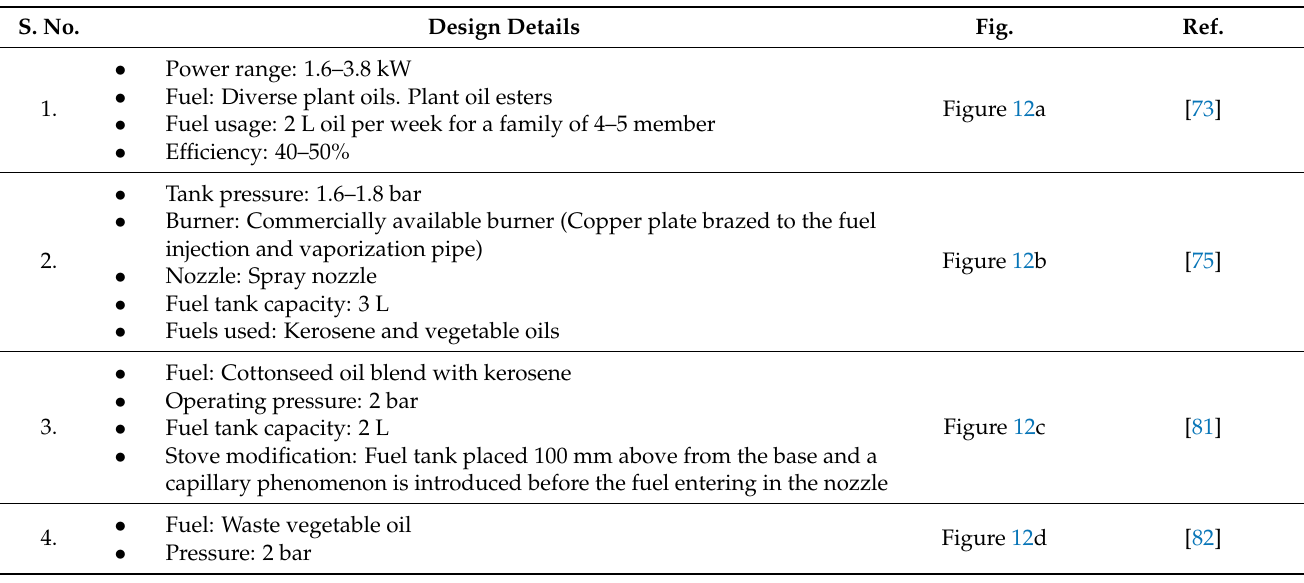
Table 4. Summary of the plant oil-based